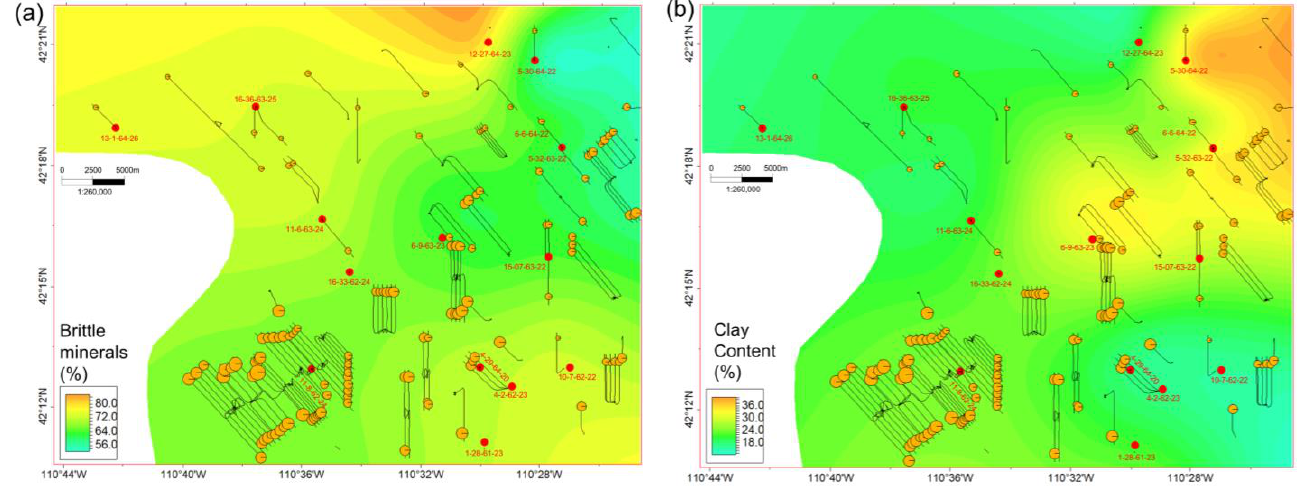
Figure 6. Map view of ( a ) brittle minerals (%) (i.e., quartz plus feldspar and calcite minerals) and ( b ) clay content (%). The grey circle represents the 1-year gas production equivalence per stage for horizontal wells, scaled by production values.